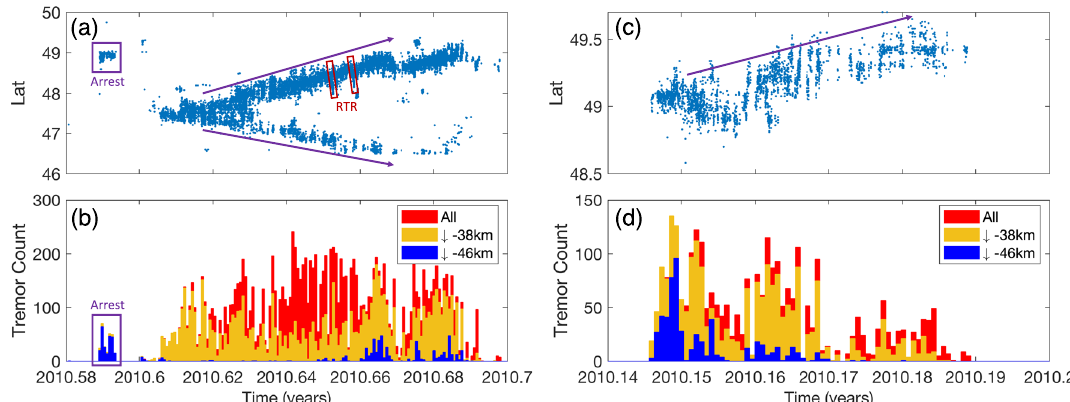
Fig. 2 Spatiotemporal distribution of episodic tremor and slow-slip (ETS) in the northern segment of Cascadia subduction zone. a , b show an example of “ major ETS ” in 2010. a Tremor catalog as a function of time and latitude. b Corresponding tremor activity binned in 6-hour interval, similar to Fig. 1b – d. The “ major ETS ” nucleates at mid-depth range and propagates both along-strike (indicated with purple arrows in ( a )) and up-dip (color-coded distribution in ( b )), with signi fi cant tremor activities at shallow depth after the initial phase. Purple boxes show the localized (arrested) deep ETS ( “ deep arrested ETS ” ). Examples of rapid tremor reversals (RTRs) are indicated with red boxes. c , d An example of “ deep ETS. ” Figure convention follows a , b